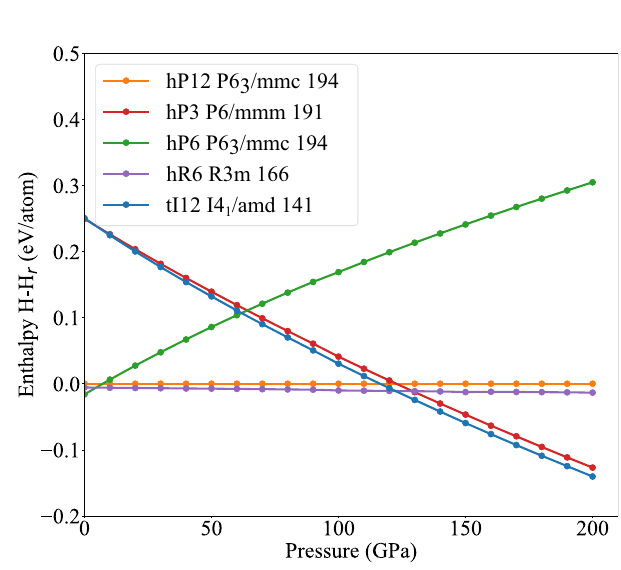
Fig. 3| Enthalpyofvariouscompeting phasesofWB 2 asa functionofpressure. The hP6 phase of WB 2 has the lowest enthalpy at ambient pressure, and the enthalpies of hP12 and hR6 structures are higher only 16 and 7meV/atom, respectively.